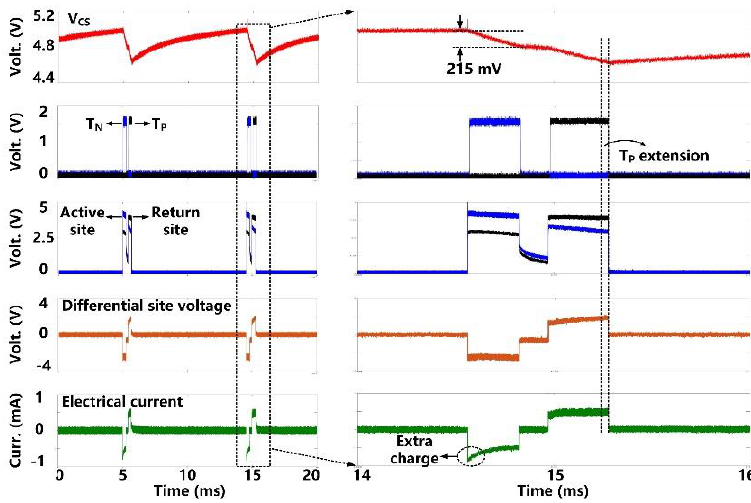
Figure 10. Measured electrical stimulation waveforms with active charge balancing.